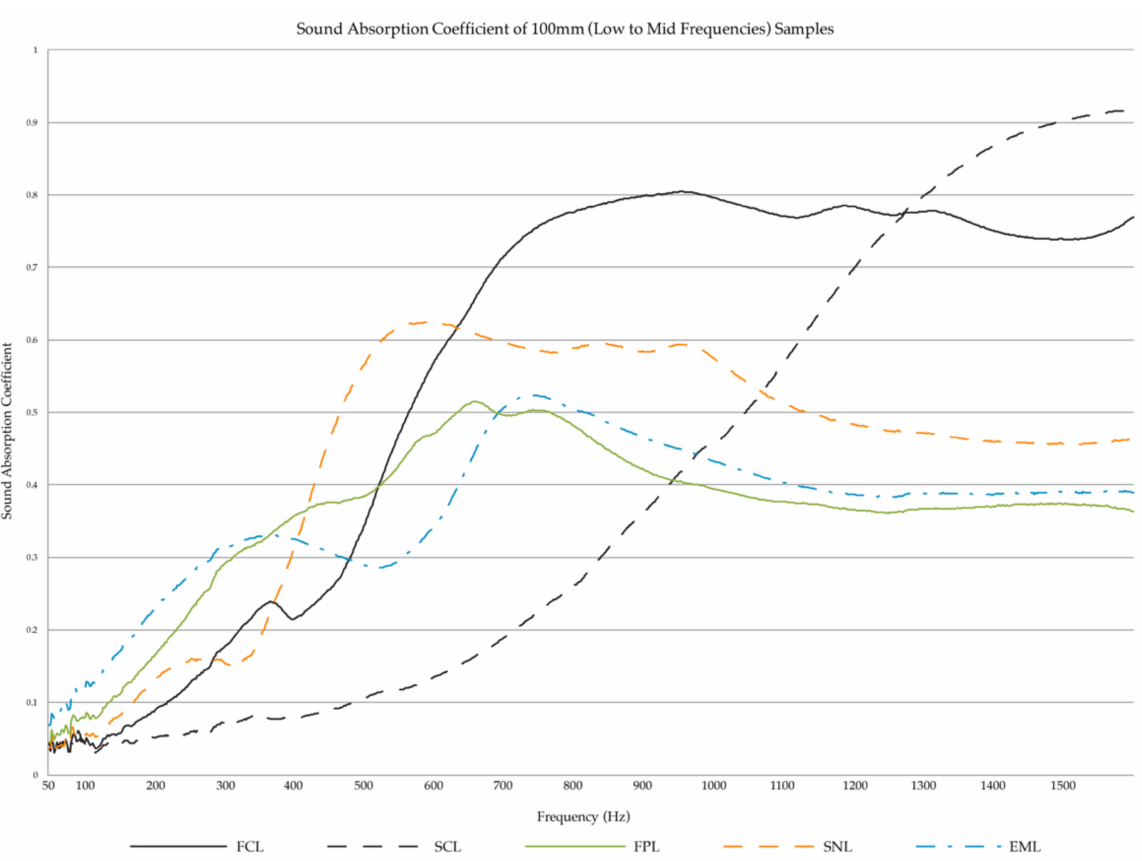
Figure 7. Sound Absorption Coefficient of low-frequency samples (100 mm).